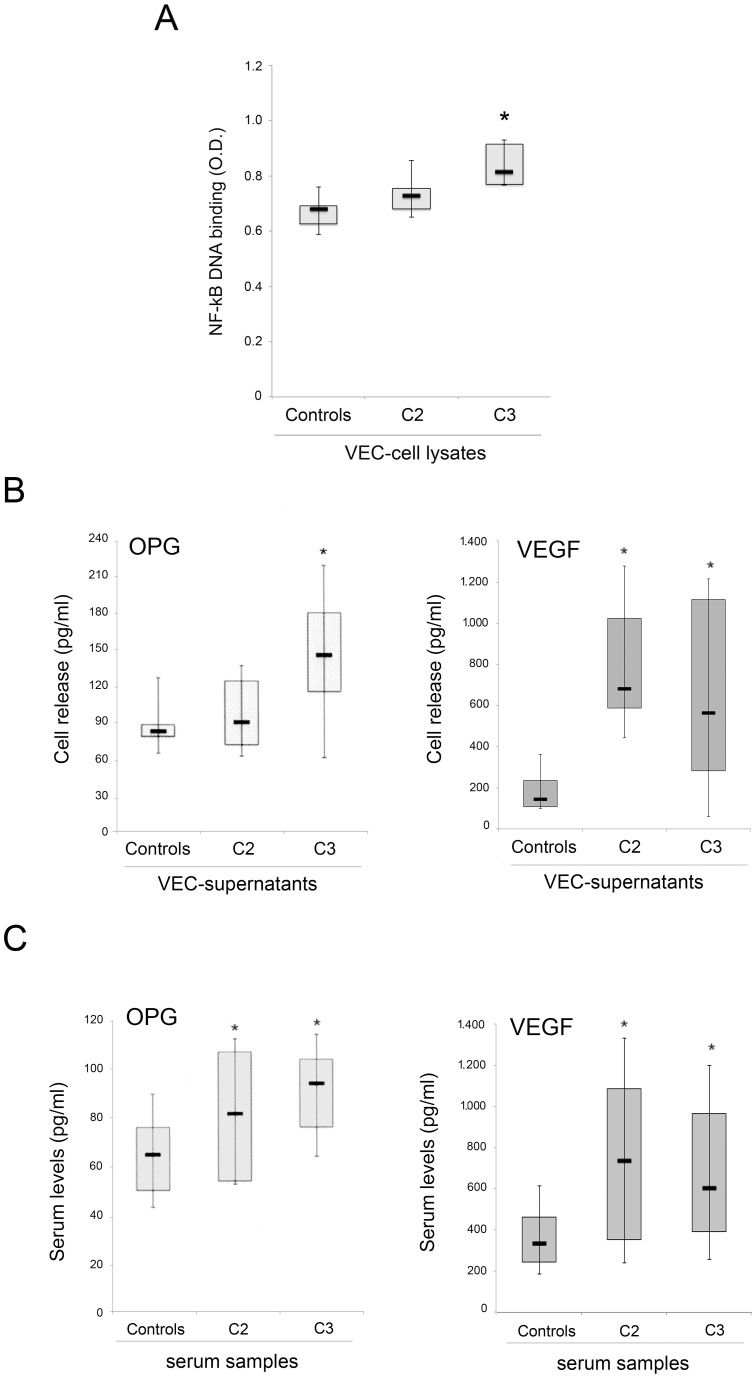
Analysis of the NF-kB, OPG and VEGF levels in VEC culture supernatants and serum samples.In A, NF-kB-p65 DNA binding activity was assessed in duplicate using the TransAM assay. Results are reported as absorbance values (O.D.) per 20 µg of cell lysate protein. In B, OPG and VEGF levels were determined by ELISA in VEC culture supernatants. In C, OPG and VEGF levels were determined by ELISA in sera of C2 and C3 patients as well as in sex and age-matched normal controls. In A–C, horizontal bars are median, upper, and lower edges of box are 75th and 25th percentiles; lines extending from box are 10th and 90th percentiles. *, P<0.05 compared to either control VEC (A–B) or control sera (C).